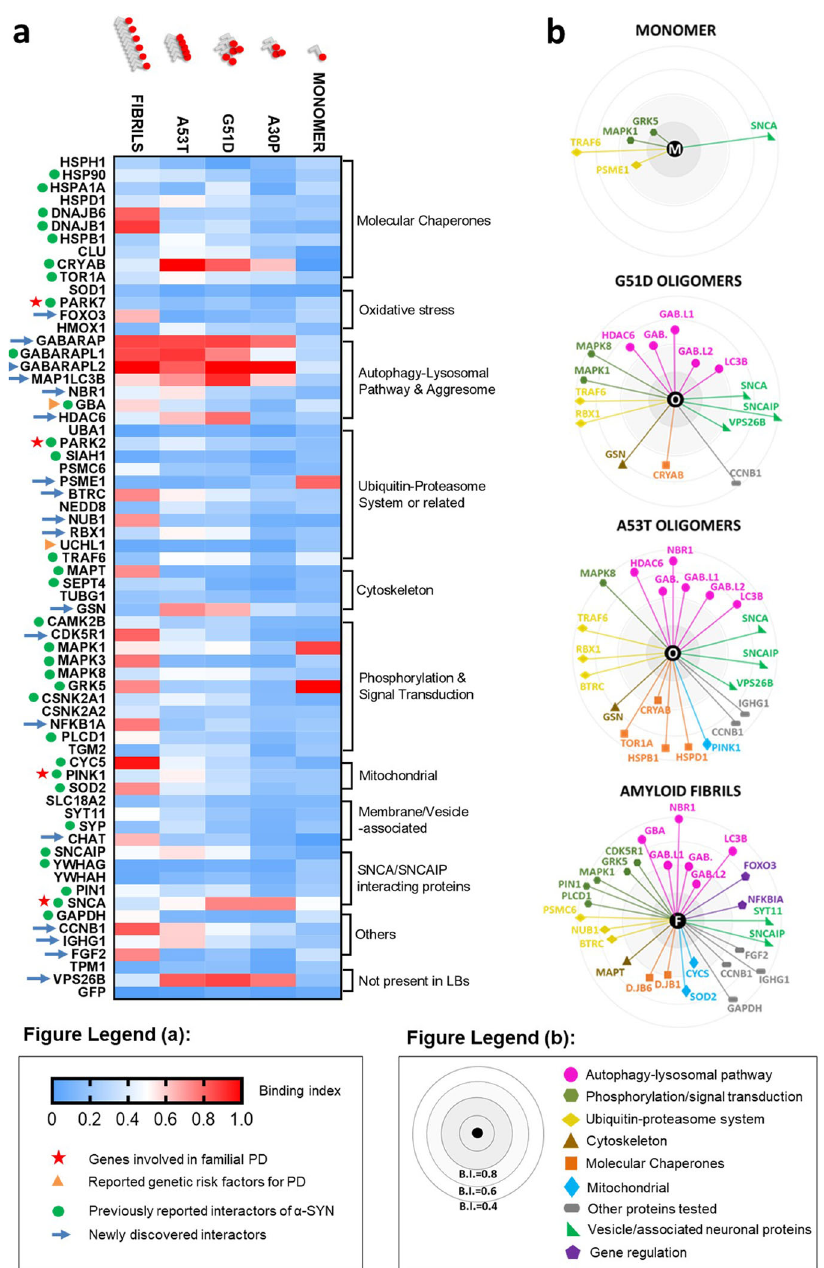
Fig. 7 The interactome of α -synuclein in the Lewy bodies. a Heatmap of interactions re fl ects binding indexes, distributed from the highest (BI = 1) to the lowest (BI = 0), based on Association Quotients ( Q ) from TCCD data and maximum luminescence using AlphaScreen proximity assay. Each colour depicts the average of triplicate measurements of one pairwise interaction with a LB component. Proteins are organized broadly, based on biological process. Previously identi fi ed PPIs (as described in BIOGRID) and genetically relevant proteins are highlighted. b Binding indexes allowed for representation of individual interactomes for each species of α -SYN tested (M — monomer, O — G51D/A53T cell-free aggregated species and F — amyloid fi brils). Proteins are grouped by biological process and distance to the centre represents magnitude of binding